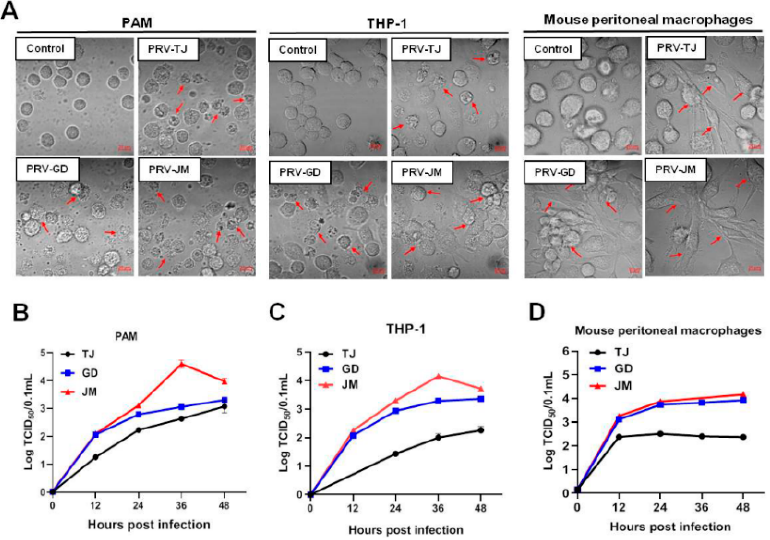
Figure 2. In vitro proliferation properties of PRV-TJ strain, PRV-GD and PRV-JM isolates. ( A ), CPEs in PAMs, THP-1 cells and mouse peritoneal macrophages, caused by PRV-TJ strain, PRV-GD and PRV-JM isolates, were characterized by the disintegrated cells (red arrows). Scale bars: 10 μ m. ( B – D ), One-step growth curves of PRV-TJ, PRV-GD and PRV-JM on PAMs, THP-1 cells and mouse peritoneal macrophages at a multiplicity of infection of 0.1.